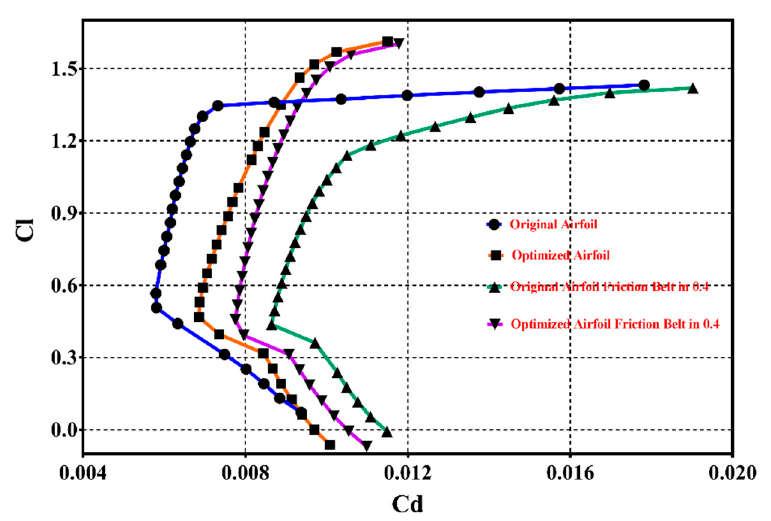
Figure 16. Comparison of aerodynamic performance after robust optimization based on triangular probability distribution.